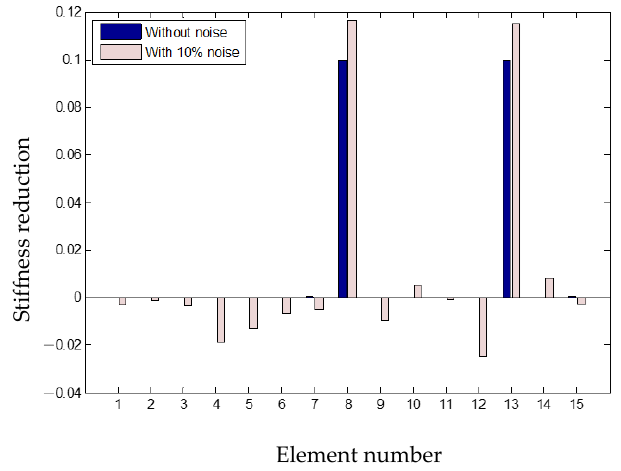
Figure 9. Damage identification result (scenarios 3 and 4).